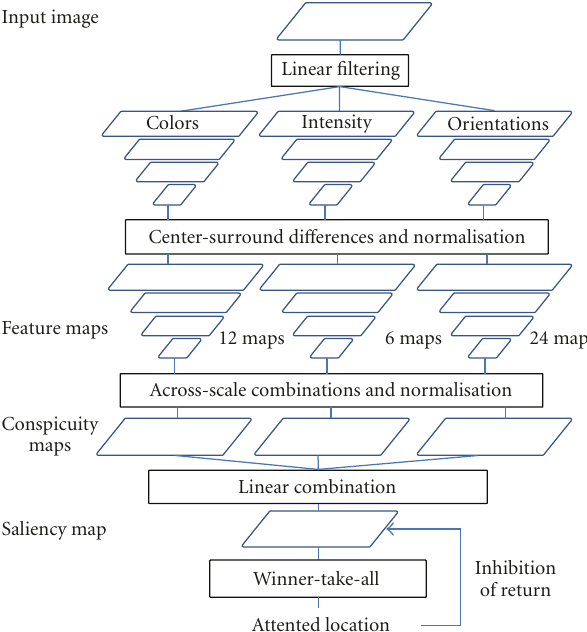
Figure 1: Visual attention